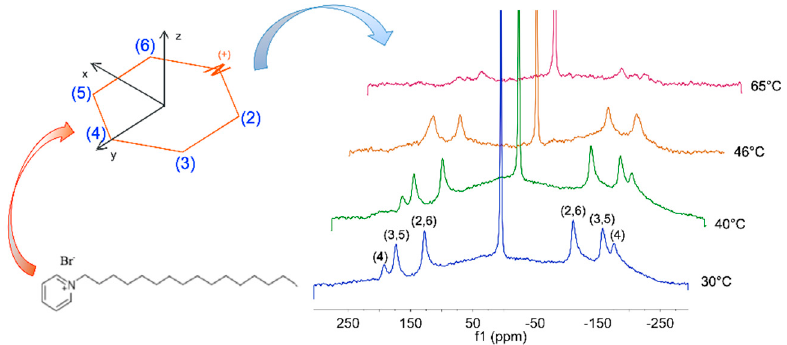
Figure 9. Clockwise, from left bottom to right. CPB molecular structure; pyridinium head group numbering and related axes for order parameters; 2H-NMR integrals comparison of SdS/ CPB related to (bottom to top) 30 °C, 40 °C, 46 °C, and 65 °C. Signals corresponded to the fully deuterated head group of CPB . CPB , cetylpyridinium bromide; SdS, sodium decyl sulfate.